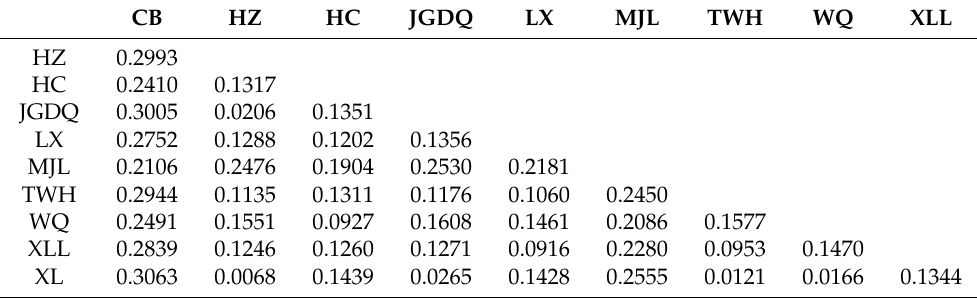
Table 4. Pairwise differentiation (F ST ) among provenances of Chosenia arbutifolia